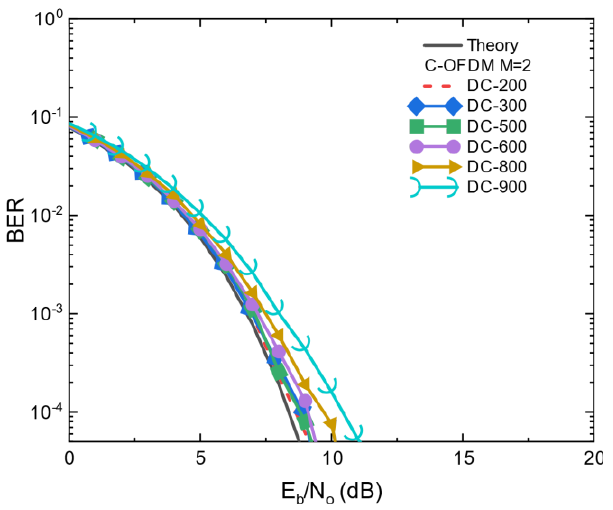
Figure 11. BER performance as a function of E b /N o for F-OFDM with 2-PAM and 600 AC.